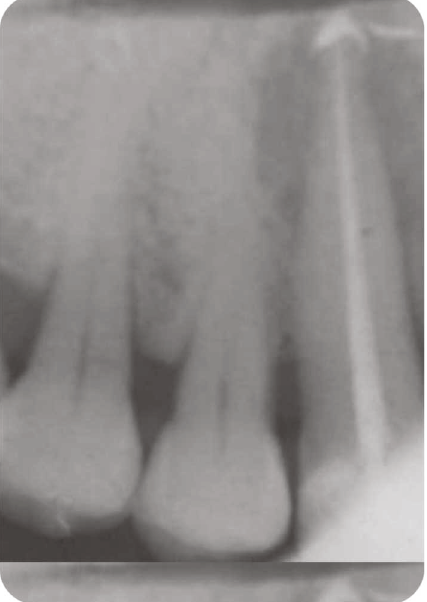
Figure 4: RCT and tridimensional fi lling with Therma fi l — suspicion of lateral